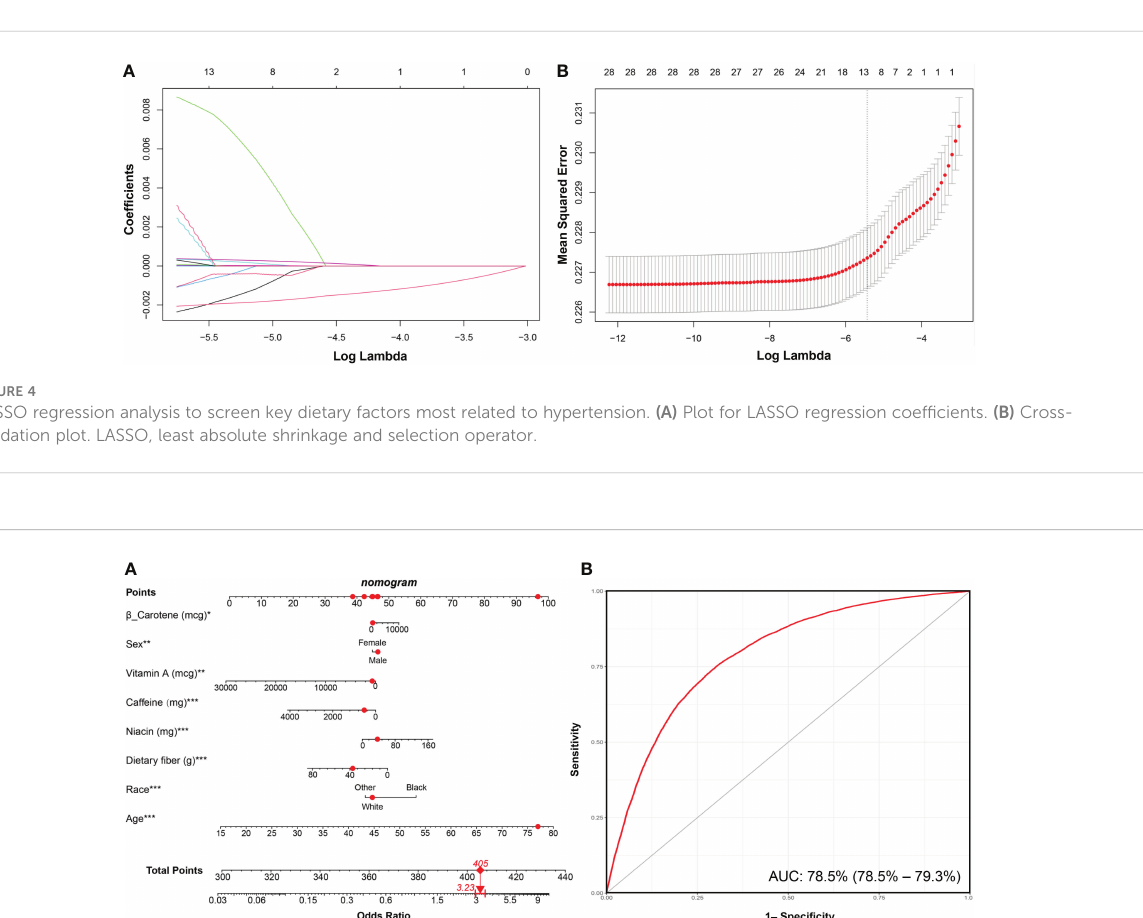
FIGURE 5 Nomogram model established for predicting the risk of hypertension and its ROC curve. (A) Nomogram model based on the key dietary factors screened by LASSO regression, and the red points show an example. For 77-year-old male participants with hypertension, the probability of hypertension increased by 3.23-fold. (B) ROC curve for evaluating the diagnostic power of the nomogram model in this study. *** p < 0.001, ** p < 0.01, * p < 0.05.